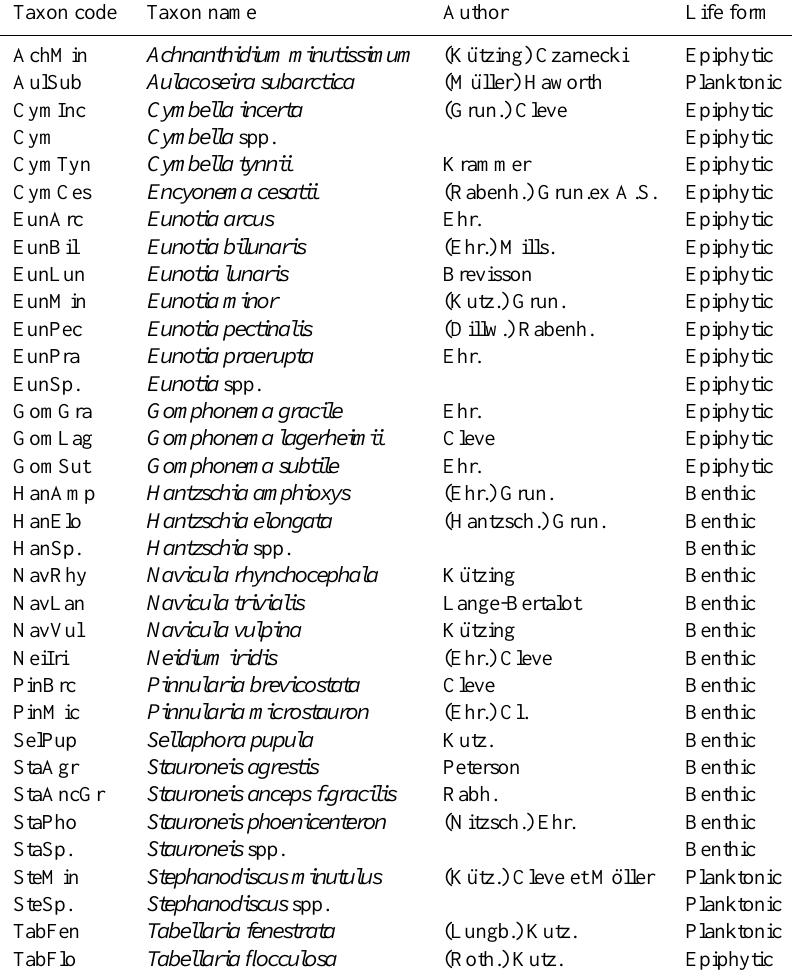
Table 1. Summary list of determined diatom taxa (Core C), with life form information. Taxon code